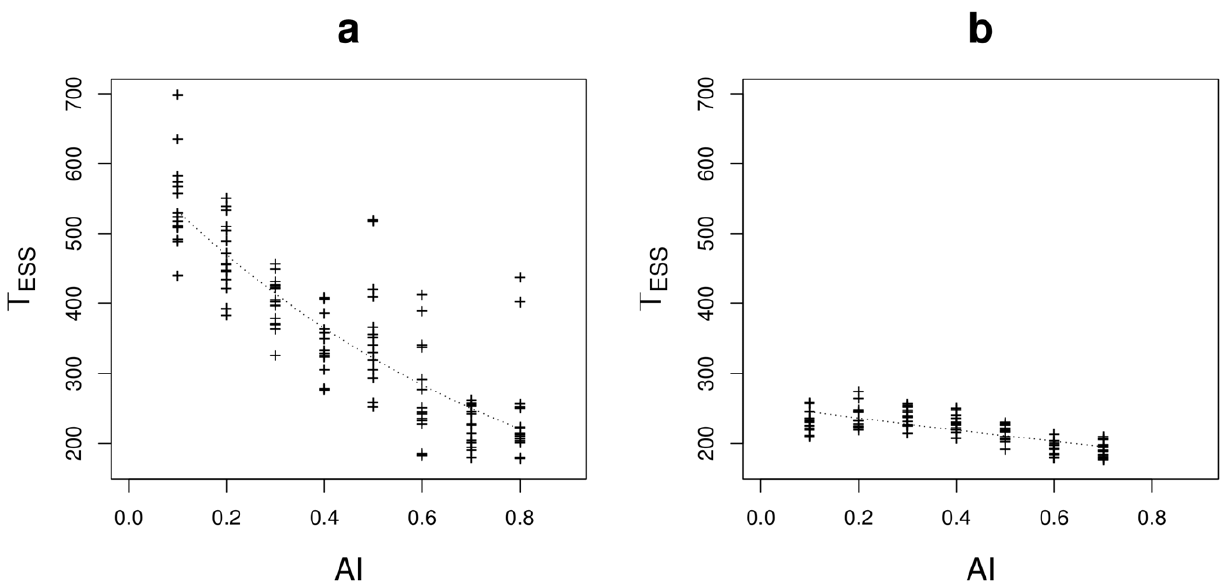
Figure 8. Time to reach the ESSs ( T ESS ) plotted against the aggregation level of habitat 2 ( AI ) for situation A (a) and situation B (b). The relationship between T ESS and AI was tested by a GLM with Poisson distributed errors (dotted line). Other parameters are for a: m s ~ 75% , d = s ~ 1 : 1 ( d ~{ b 1 ~ b 2 ~ 1 : 1 and s ~ 1 ) and p ~ 0 : 32 ; for b: m s ~ 15% , d = s ~ 1 : 1 ( d ~{ b 1 ~ b 2 ~ 1 : 1 and s ~ 1 ) and p ~ 0 : 16 . The lattice environment was used.